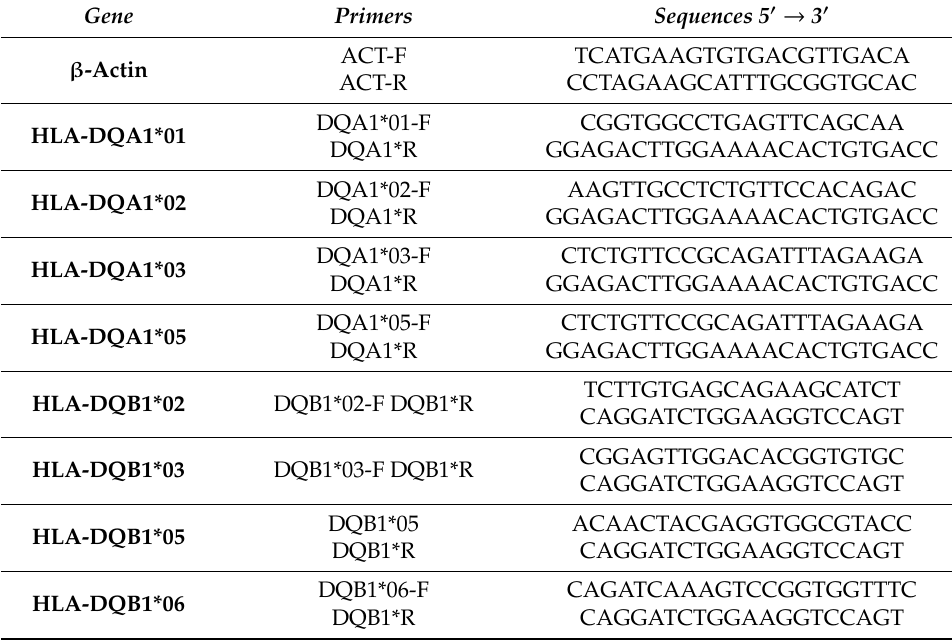
Table 2. Primers used for